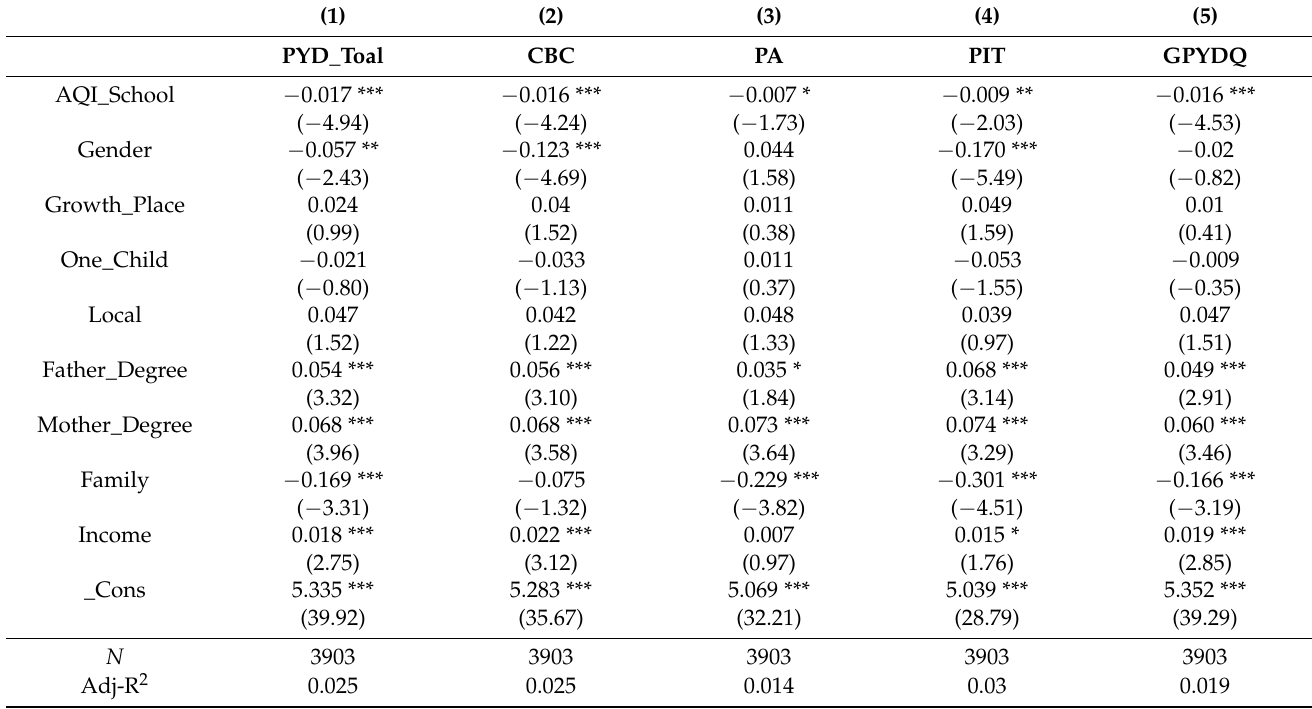
Table 4. The results of multiple regression analysis.